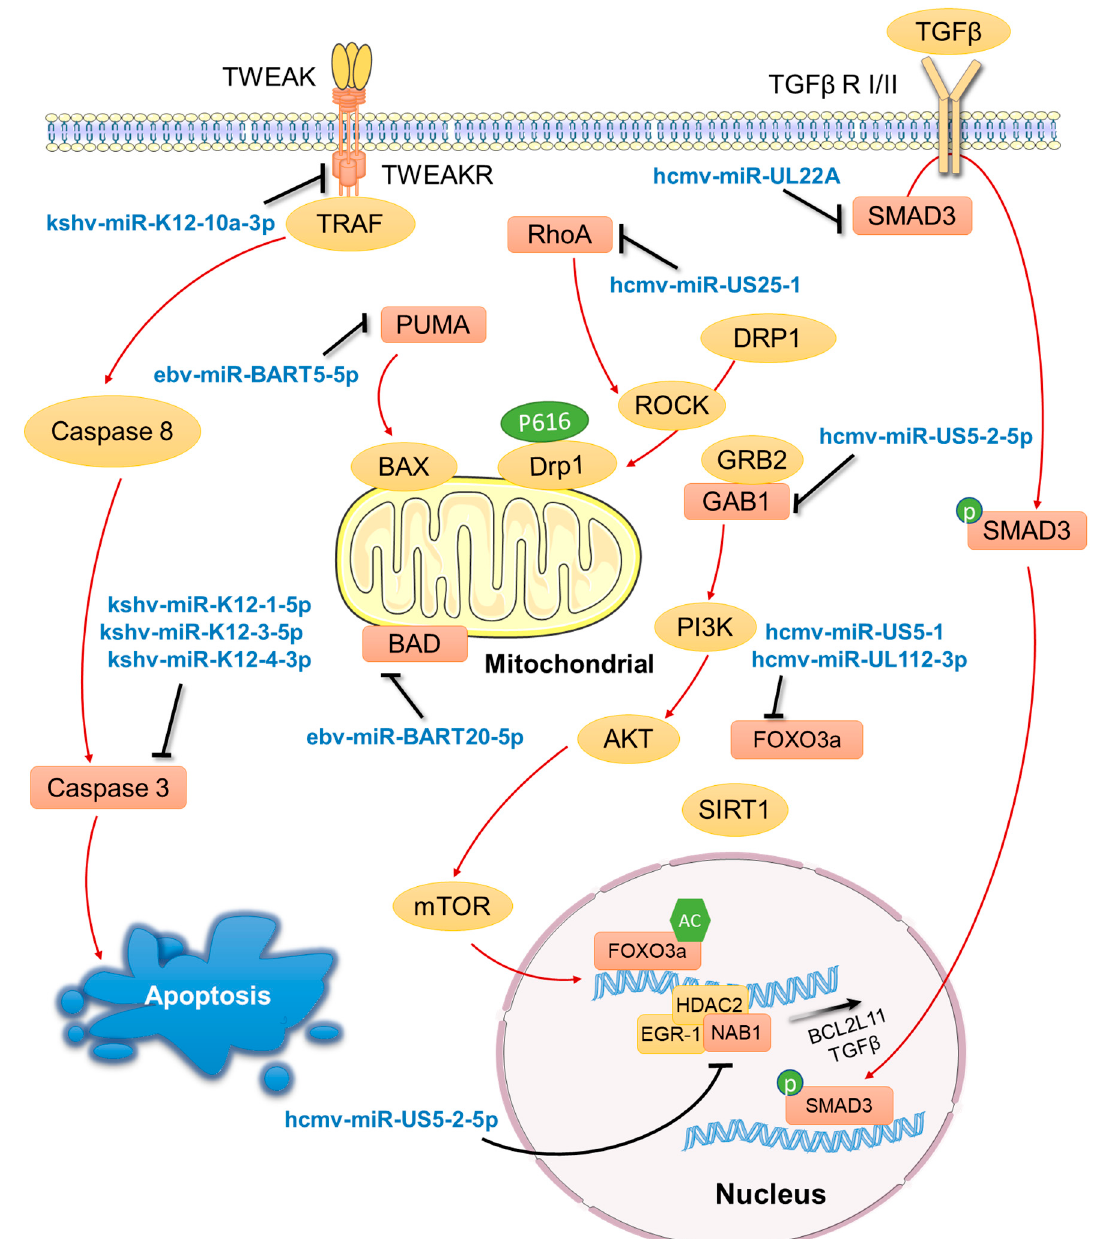
Figure 3. Regulation of apoptosis pathways by viral and cellular miRNAs. The genes directly targeted by miRNAs are indicated by orange rectangles. Green patterns represent protein modification. Some graphic elements were obtained from Servier Medical Art (SMART) (https://smart.servier.com/ (accessed on 12 May 2022)).